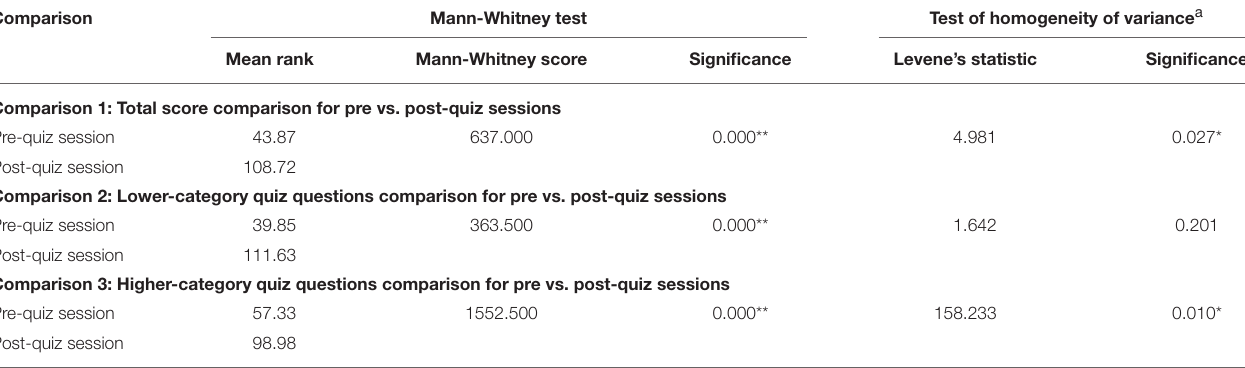
TABLE 4 | Mann-Whitney comparison of scores between pre and post-quiz sessions.